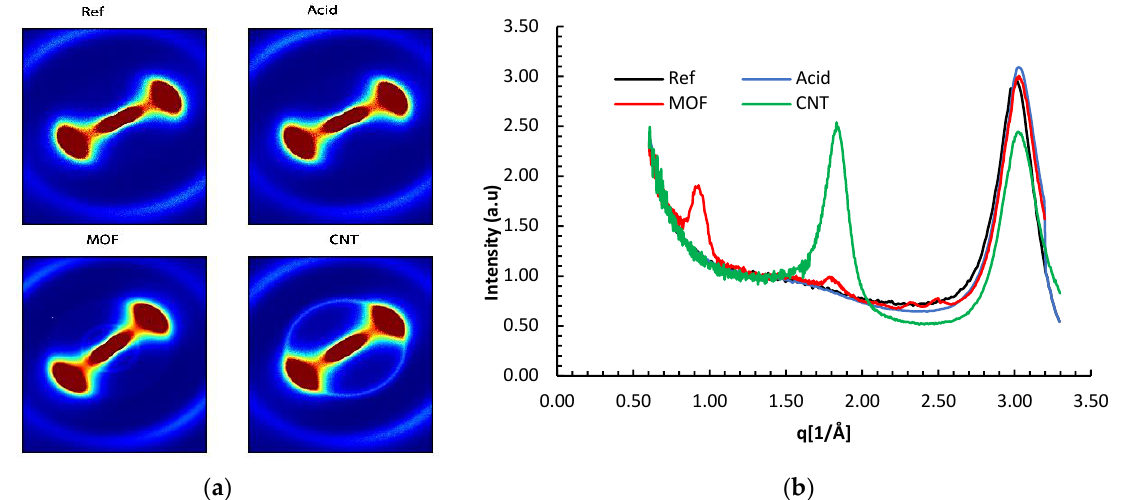
Figure 3. ( a ) Two-dimensional WAXS patterns of the different carbon fibers configurations, and ( b ) WAXS profiles of the AS4 carbon fibers after the different surface treatments.